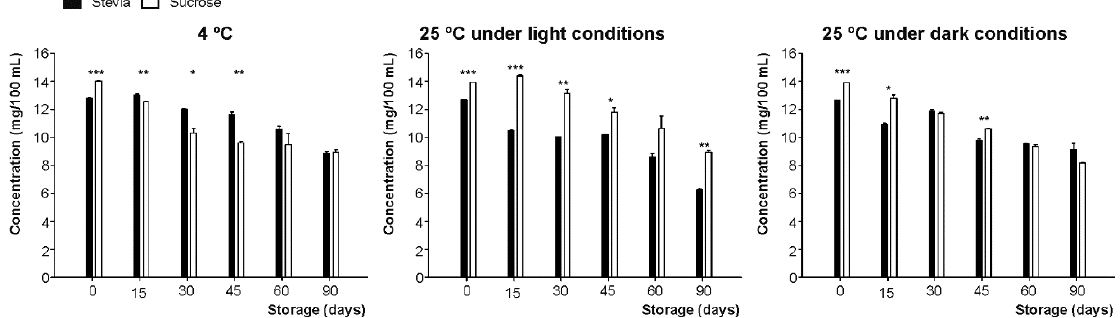
Figure 4. Content of total flavanones (mg/100 mL) of juices developed using stevia and sucrose as sweeteners, measured during storage for 90 days under three different conditions (4 °C and 25 °C under light conditions and 25 °C under darkness conditions). Bars with asterisk(s) are significantly different according to the paired t -test developed at p < 0.05 (*), p < 0.01 (**) and p < 0.001 (***).